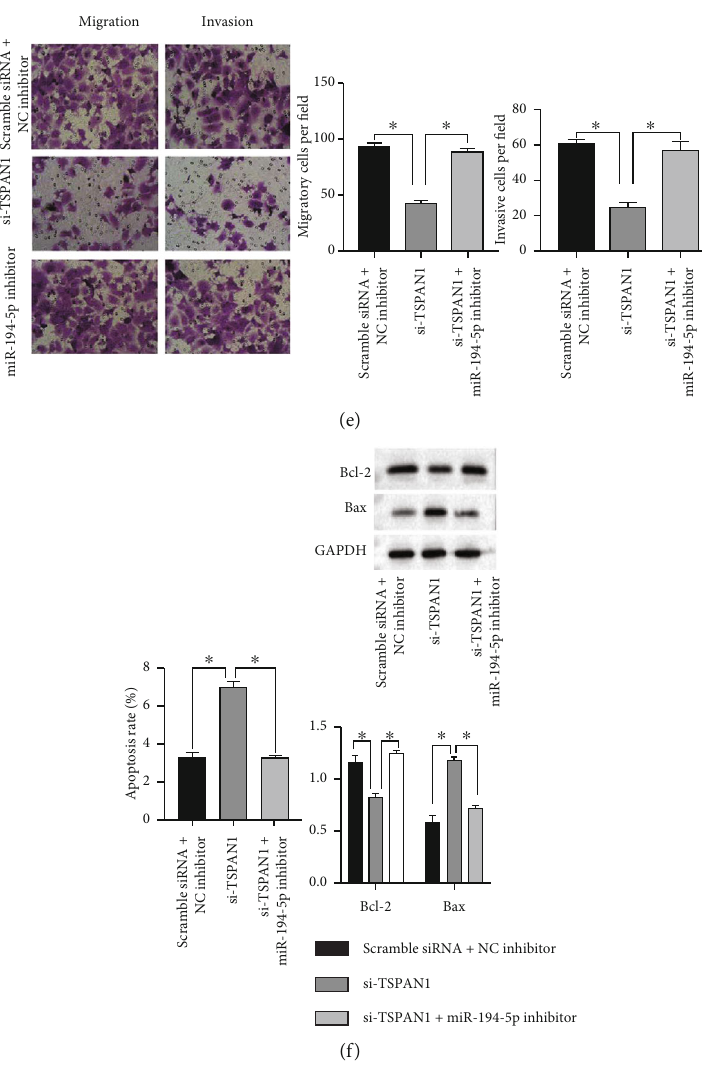
Figure 4: miR-194-5p leads to a targeted inhibition of TSPAN1 and regulates OC cell behaviors by targeting TSPAN1. (a) Database analysis and luciferase activity assays showing targeted inhibition of TSPAN1 by miR-194-5p. (b) GEPIA 2 database analysis, qRT-PCR detection, and western blotting analysis showing TSPAN1 is upregulated in OC. (c) qRT-PCR detection and western blotting of TSPAN1 expressions in A2780 cells following transfection with si-TSPAN1 and/or miR-194-5p inhibitor. (d) CCK-8 assay detection of A2780 cell viability following transfection with si-TSPAN1 and/or miR-194-5p inhibitor. (e) Representative migratory or invasive A2780 cells per fi eld and numbers of migratory or invasive cells following transfection with si-TSPAN1 and/or miR-194-5p inhibitor. (f) Apoptosis rates of A2780 cells, western blots, and gray values of apoptosis-related proteins in A2780 cells following transfection with si-TSPAN1 and/or miR-194- 5p inhibitor. A symbol of ∗ represents p < 0 : 05